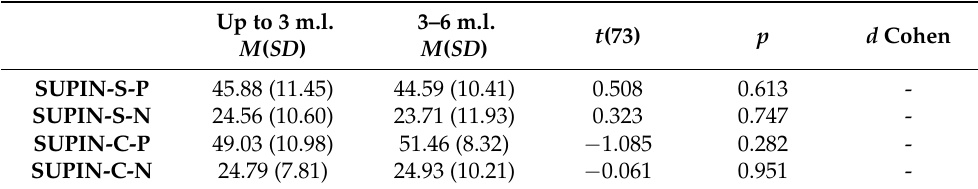
Table 8. The differences between the intensity of positive and negative emotions at first-time fathers taking into consideration the age of